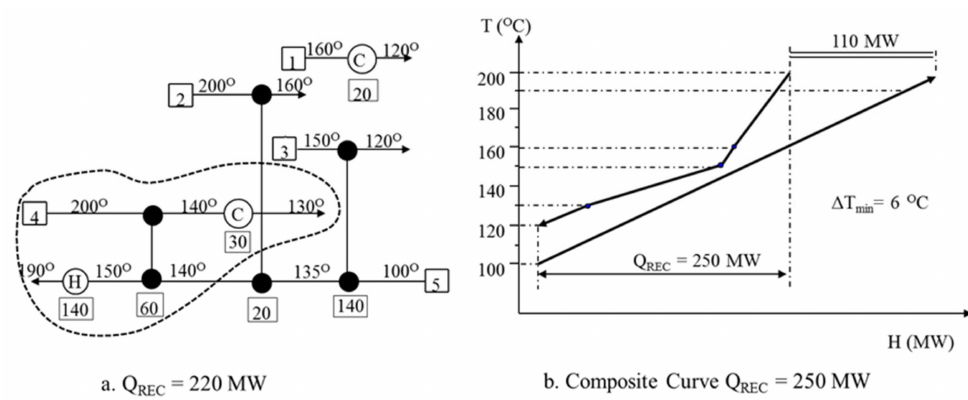
Figure 2. Maximum energy recovery.